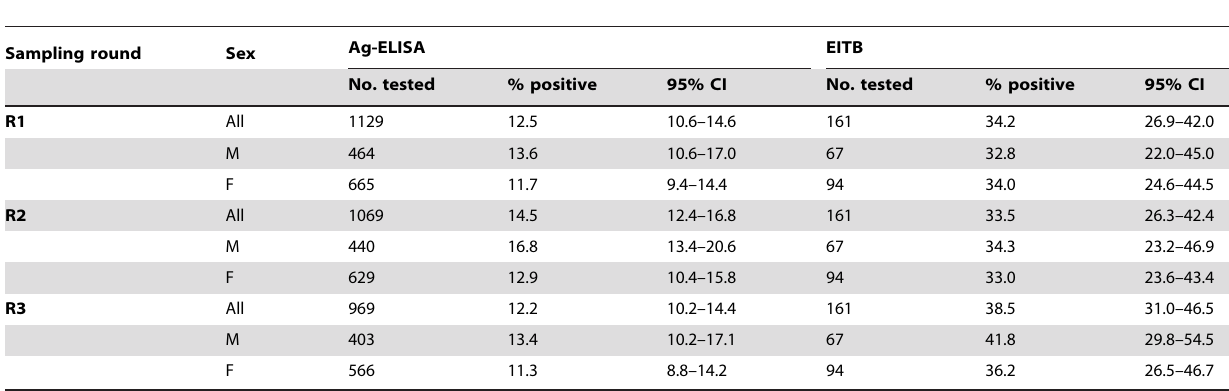
Table 1. Sero-antigen and sero-antibody cysticercosis prevalences for the three sampling rounds.